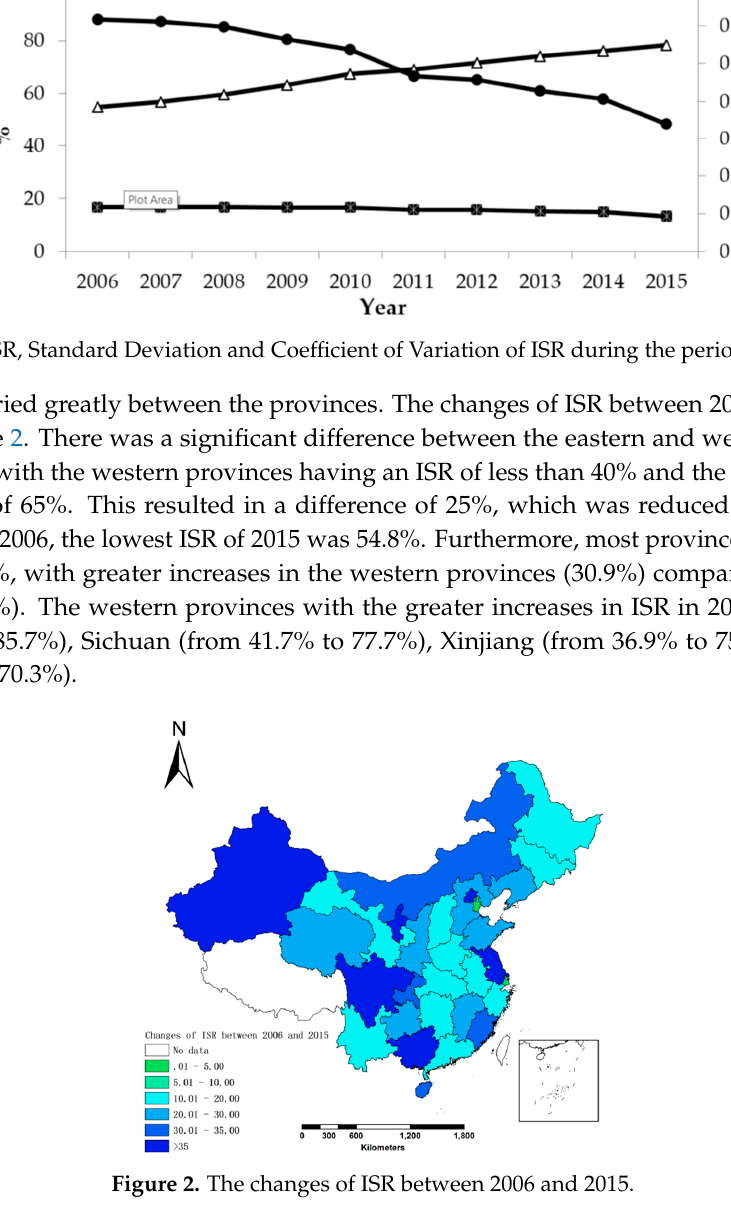
Figure 2. The changes of ISR between 2006 and 2015.